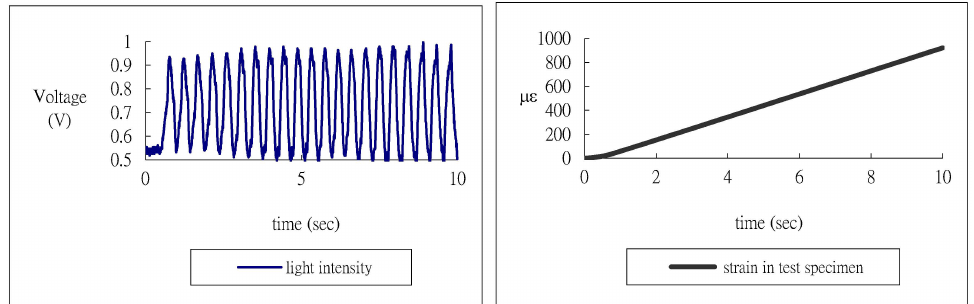
Figure 5. Light intensity of Mach-Zehnder interferometer and strain of test specimen measured by strain gauge for acrylate adhesive with bonding length 60 mm.